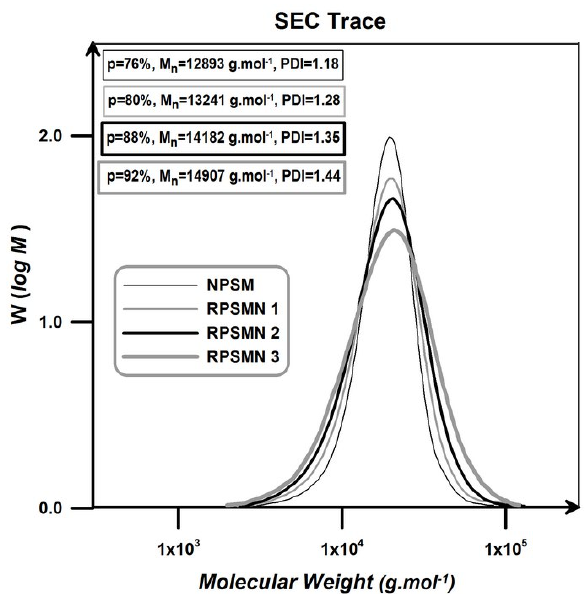
Figure 7: SEC traces of the neat random poly (styrene-co-methyl methacrylate) and its